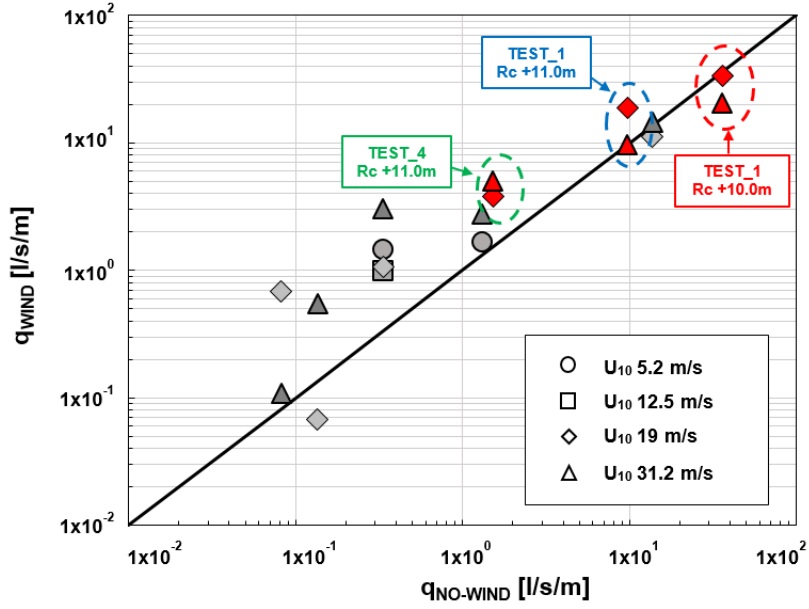
Figure 8. CFD numerical results marked with different wind speeds; red data represent breaking waves, while grey data represent non-breaking waves.